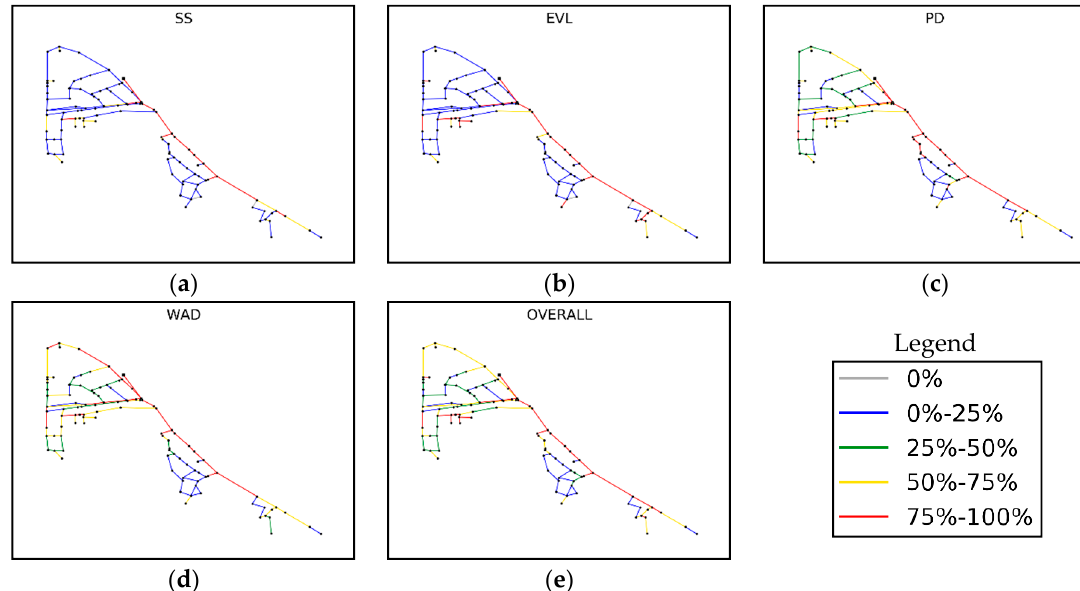
Figure 5. Critical pipe assessment for ( a ) supply shortage ( SS) , ( b ) economic value loss ( EVL) , ( c ) pressure decline ( PD) , ( d ) water age degradation ( WAD) , and ( e ) OVERALL of Network 3.